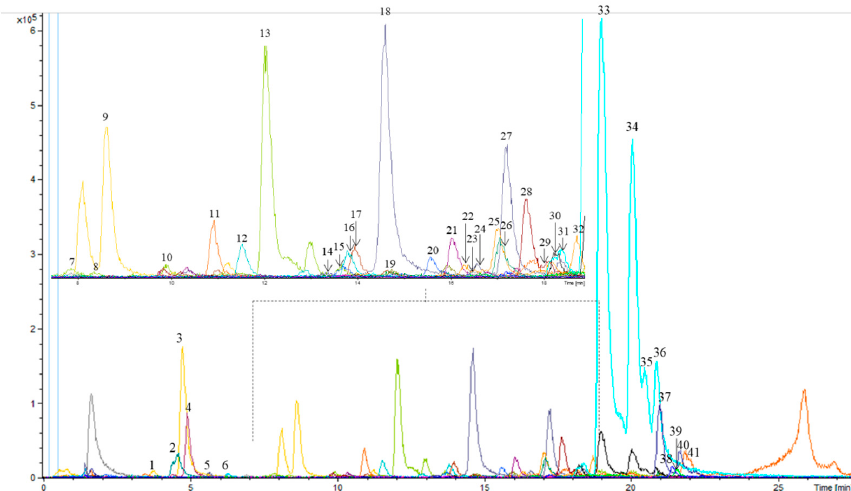
Figure 1. Extracted ion chromatogram (EIC) obtained from HPLC-ESI-TOF-MS analysis of olive leaf extract obtained by MAE. Peaks have been numbered according to the elution order.